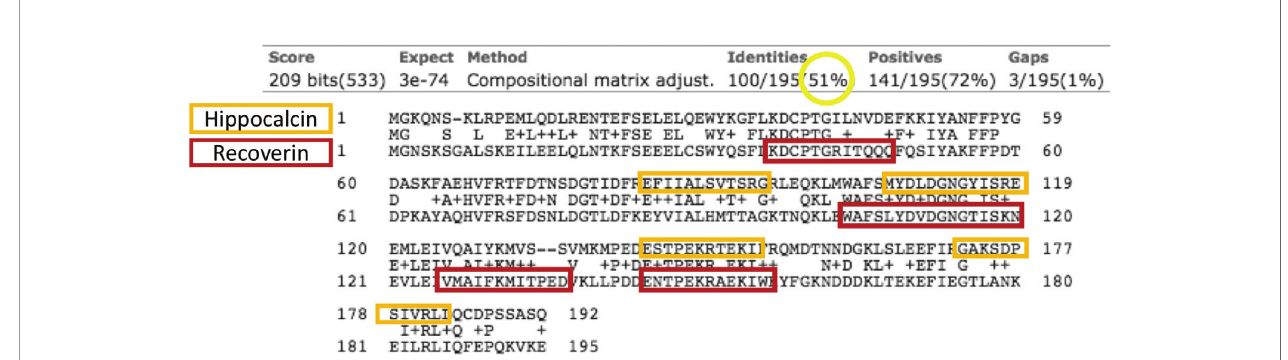
FIGURE 6 | Alignment of hippocalcin (upper row) and recoverin (lower row) sequences. In the middle lines are the matching amino acids. Circulated in yellow is the identity between the sequences, and in the orange and red boxes are the B epitopes predicted in each sequence. The arrows indicate the antigenic determinants that the proteins share.